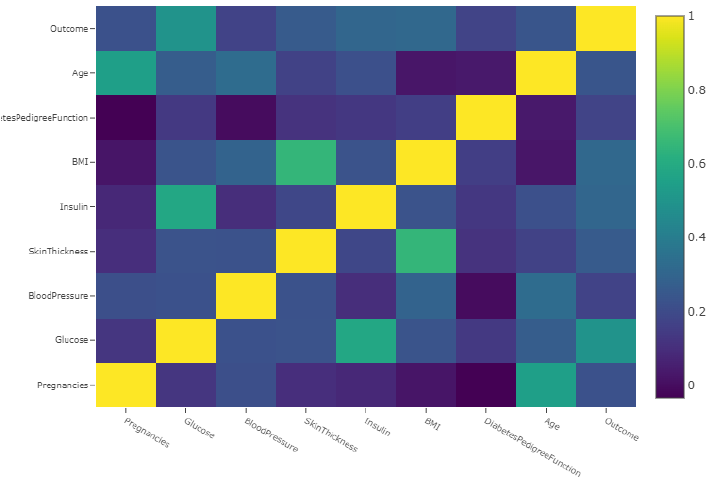
Figure 5. Feature Correlation Matrix for PIMA